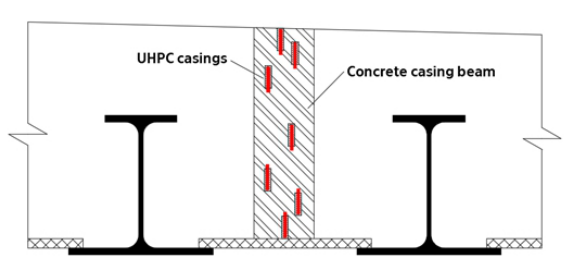
Figure 2. Example of the thermometer deployment into the bridge deck with usage of the prefabricated casing beam.